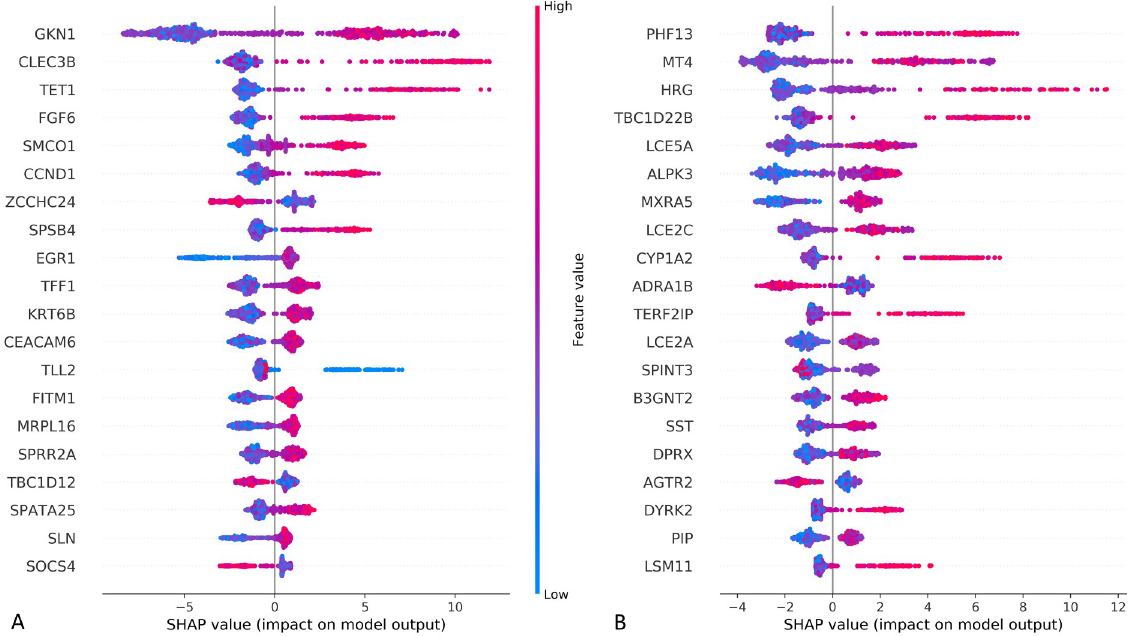
Fig 3. SHAP variable importance plots. (A) SHAP values for muscle-skeletal tissue. (B) SHAP values for the lung tissue. The plot includes all samples in the training data and the values represent the impact of the gene on model prediction output. SHAP values explain to what extent the feature (gene) contributes to the prediction of the